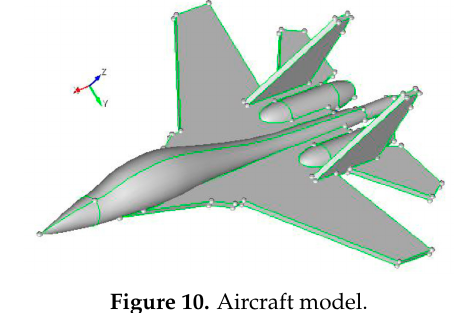
Figure 10. Aircraft model. Table 3. Example